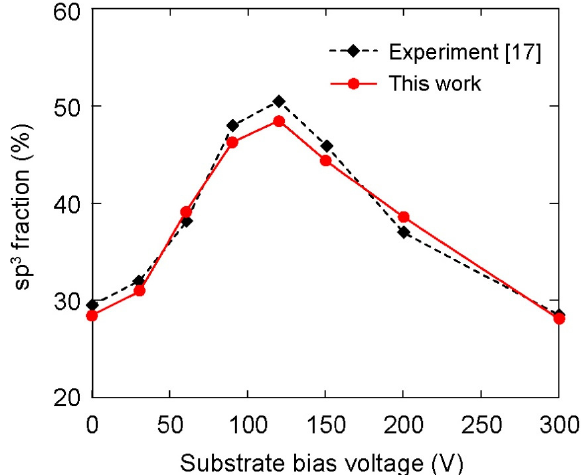
Figure 6. Effect of substrate bias voltage on overall sp 3 fraction in the DLC films. The experimental results were adopted from the previous study